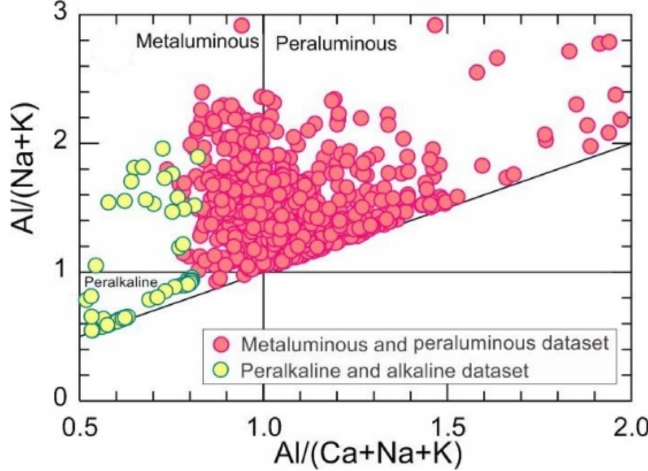
Figure 1. Variation of Al/(Na + K) versus Al/(Ca + Na + K) [42] shows the composition of selected rocks changed from peralkaline to peraluminous. The geochemical data in use in this research was collected from 994 whole rocks datasets on the http://georoc.mpch-mainz.gwdg.de/georoc/ (accessed on 29 August 2021). The 915 databases of metaluminous and peraluminous rocks through- out the world with M < 2 [M = (Na + K + 2Ca]/(Si × Al] and SiO 2 > 63% wt.% (Table S1) and the 79 peralkaline to alkaline bulk rock database with M > 2, and SiO 2 > 45wt.% (Table